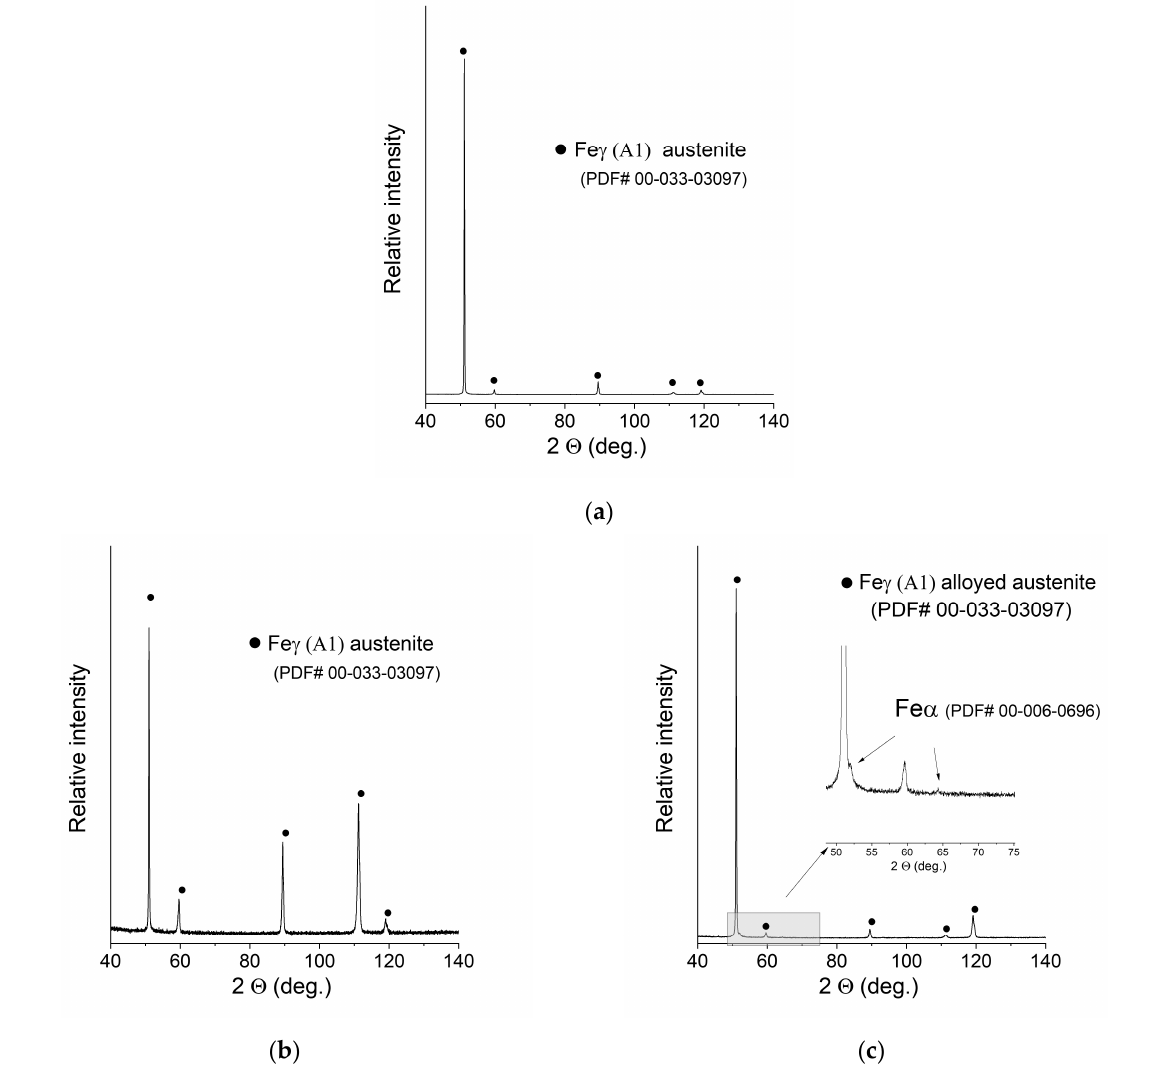
Figure 6. XRD patterns of the obtained samples: ( a ) Sample A (0.7 mm layer thickness); ( b ) Sample B (0.4 mm layer thickness); ( c ) Sample C (0.2 mm layer thickness).